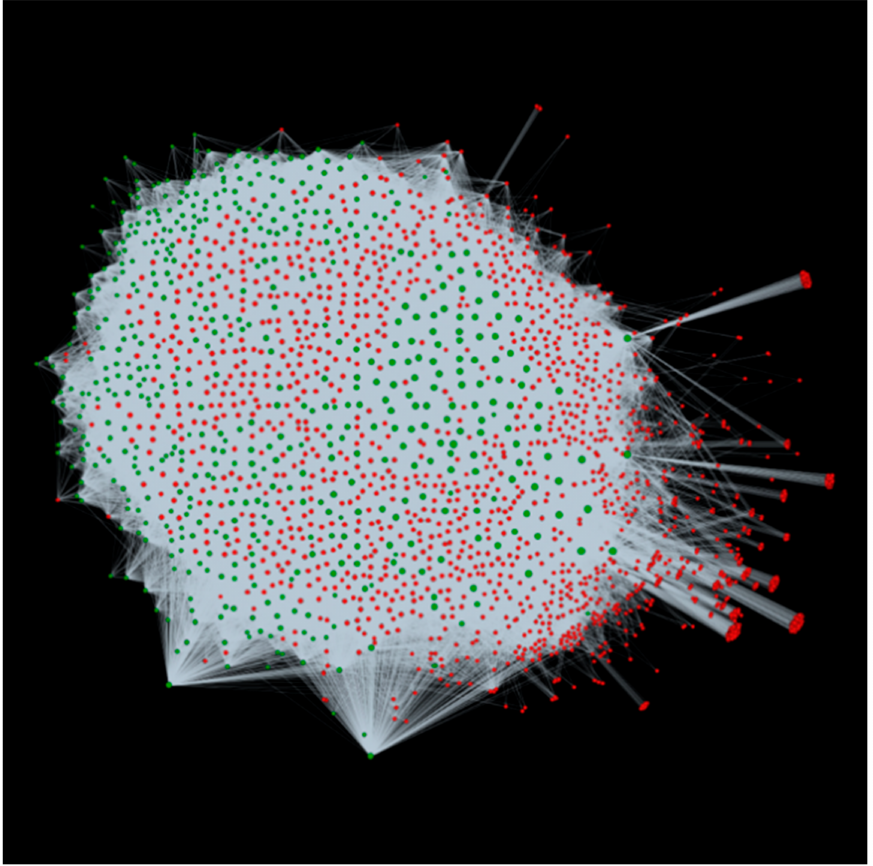
Figure 6. Visualization of the interactions for up-regulated genes of alfalfa interacting with P. syringae . Green nodes are host proteins and red nodes are pathogen proteins. Edges in grey represent the interactions from the interolog-based